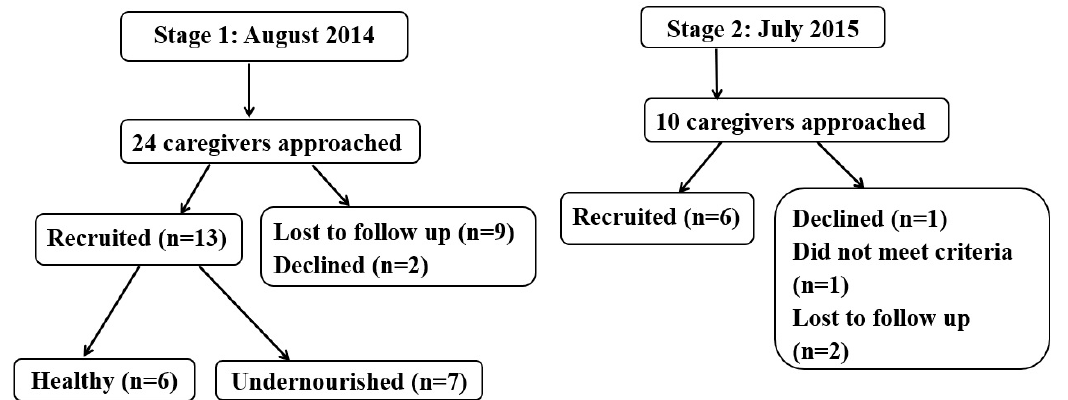
Figure 1. Participant recruitment flow. Only undernourished children were recruited at stage 2.